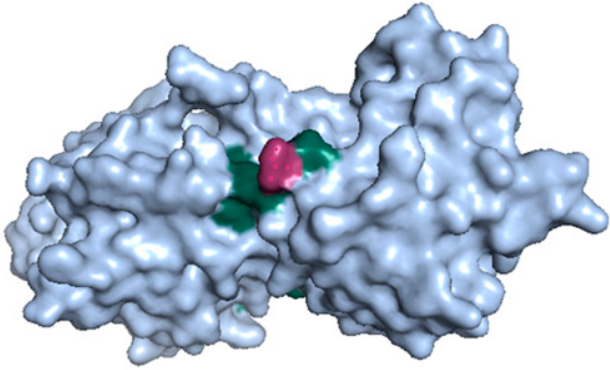
Figure 6. The 3D structure of BdcA (PDB id: 4PCV). The bdcA G135S mutation (red) is at the surface and near active site residues Ser132 and Tyr146 (green).